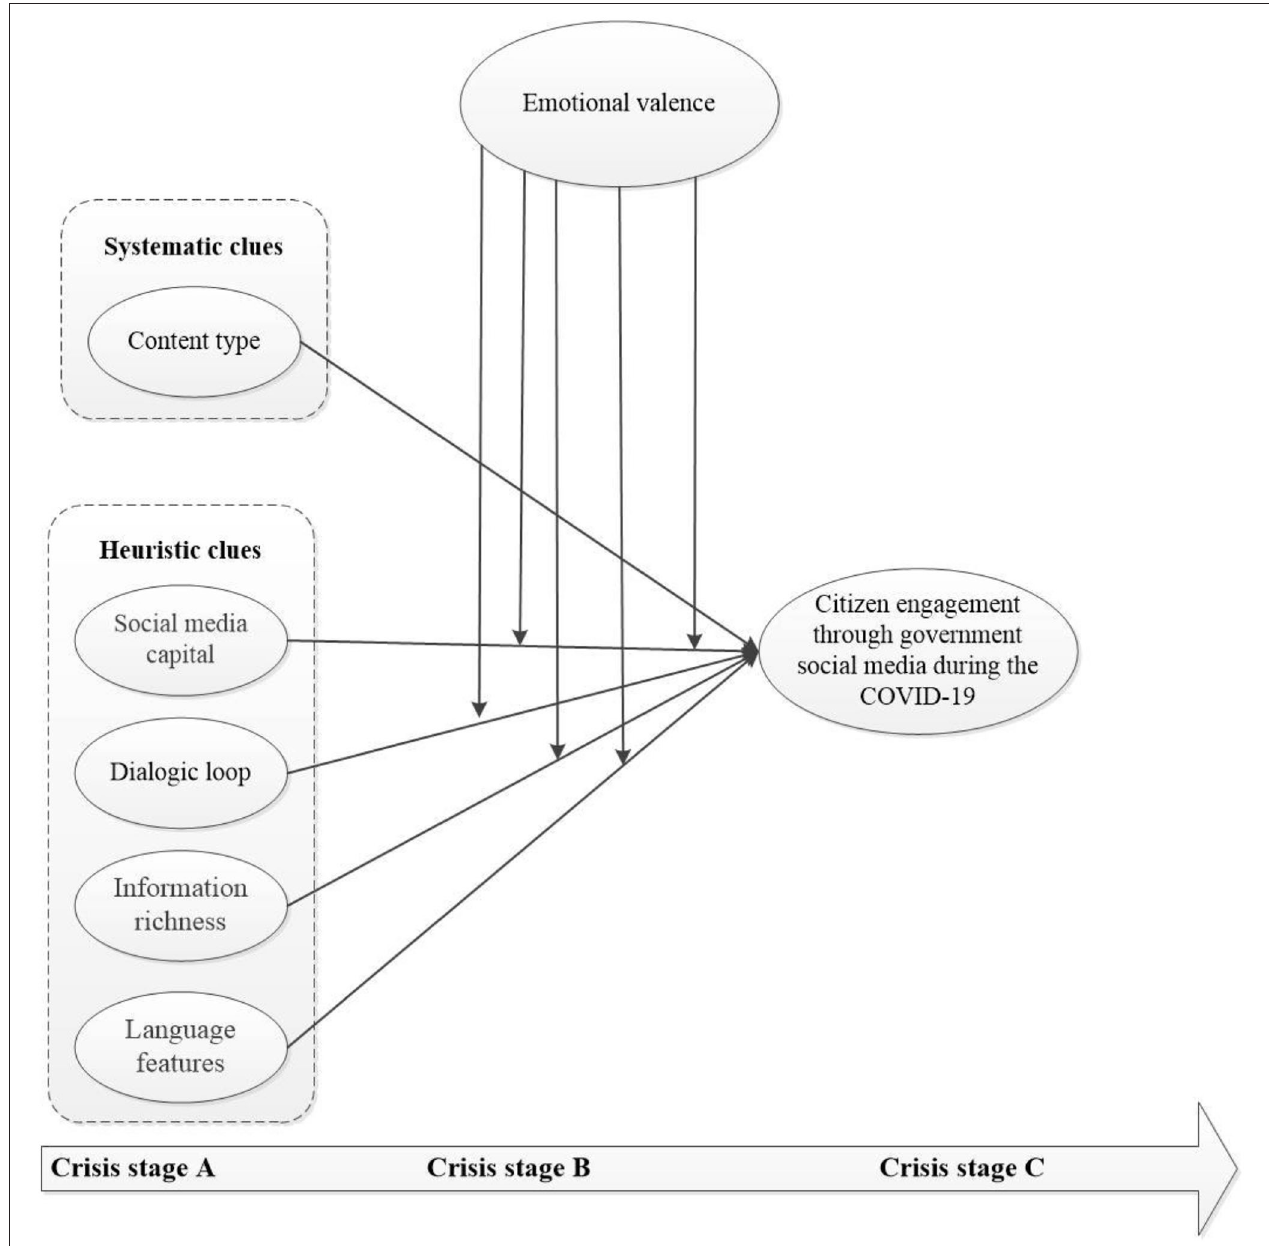
FIGURE 1 | The theoretical model of CEGSM across crisis stages.